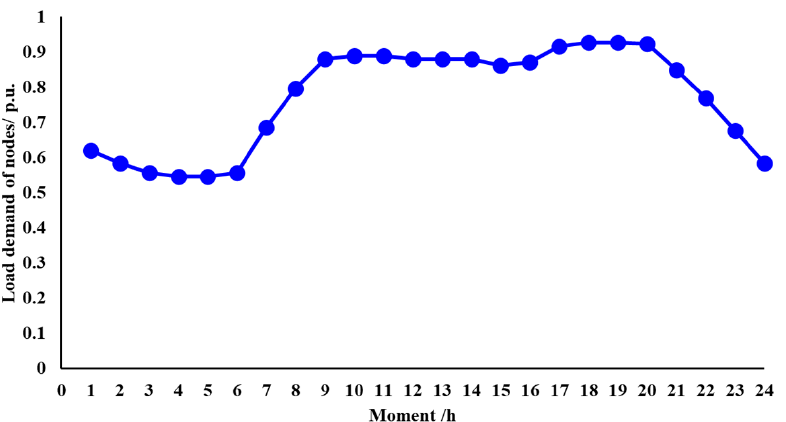
Figure A2. Load demand variation during simulation day.